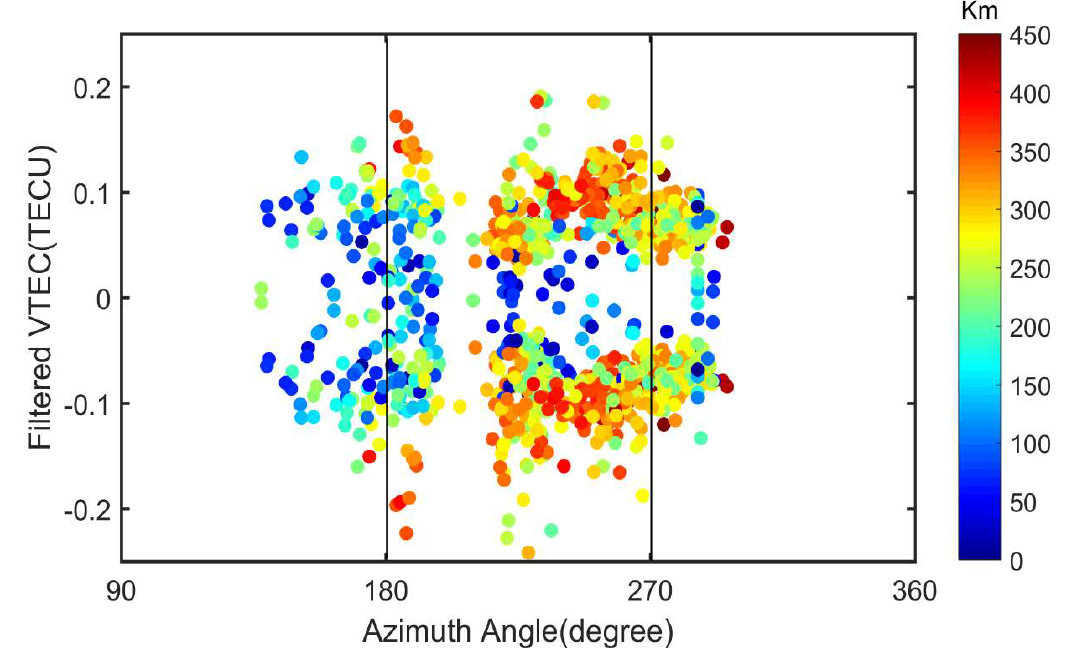
Figure 9 . Change of filtered TEC with the azimuth and the distance between the typhoon eye and the SIP.